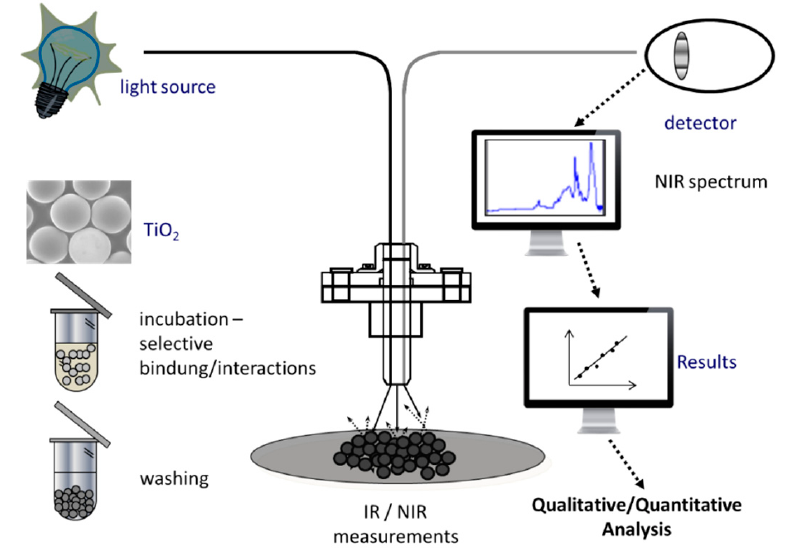
Figure 5. Principle of material-enhanced infrared spectroscopy (MEIRS).